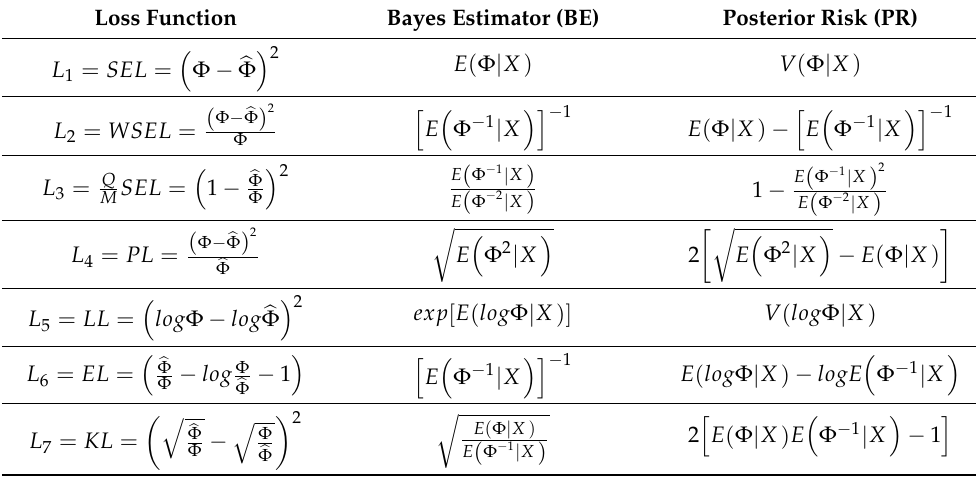
Table 1. Bayes estimator and posterior risk under different loss functions. Loss